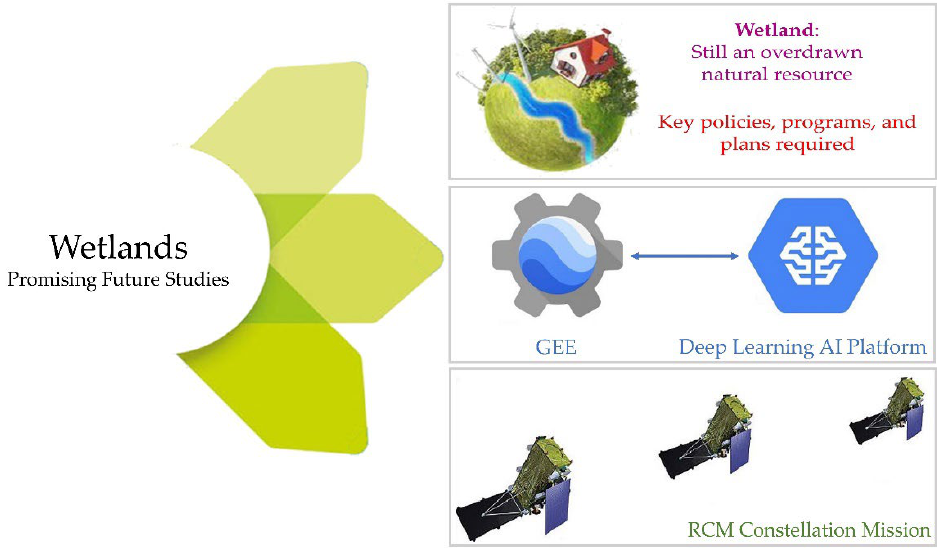
Figure 21. General overview of key recommendations for future studies to combat the challenges of wetland monitoring.